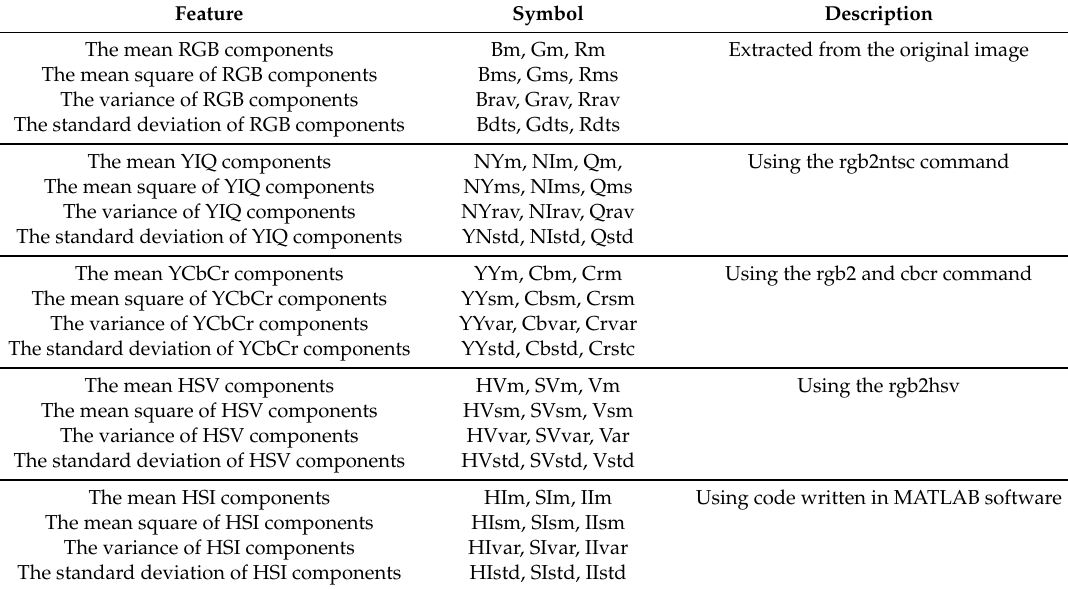
Table 1. Extracted color features for rice seeds.